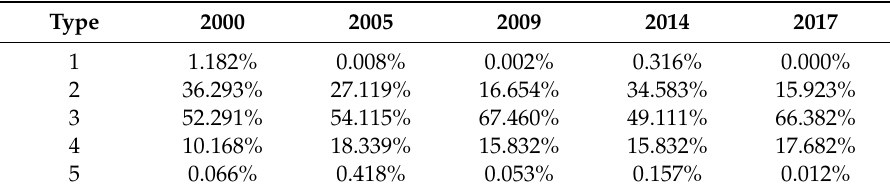
Table 3. Percentage of areas of the types of ecological regions according to the RSEI of China from